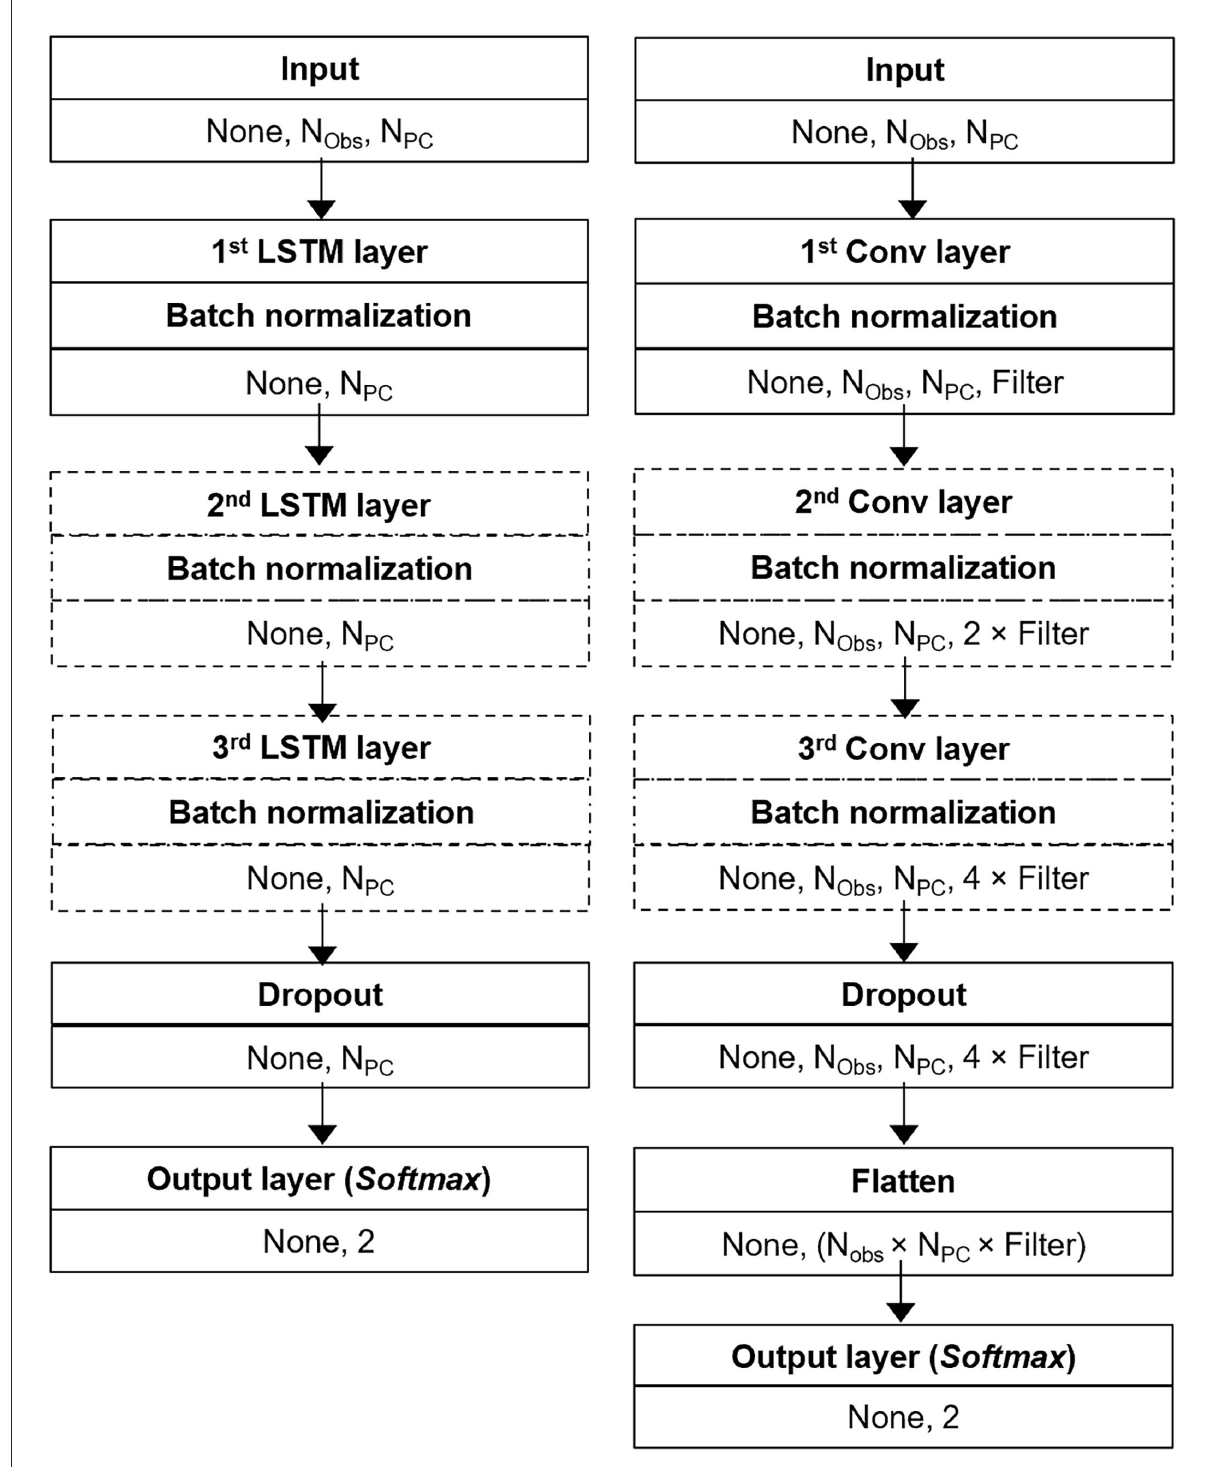
FIGURE2 Schematic illustration of the general network architectures for the LSTM (left) and CNN (right) used as secondary models in this study. The dashed lines indicate elements which were only included in some variations of the architectures being tested and compared.